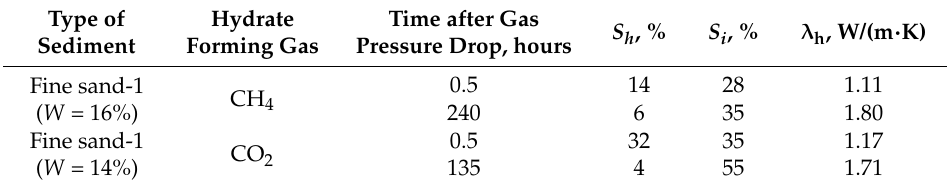
Time-dependent thermal conductivity of frozen hydrate-bearing sand samples at non-equilibrium conditions, T = − 6 ± 1 ◦ C and P = 0.1